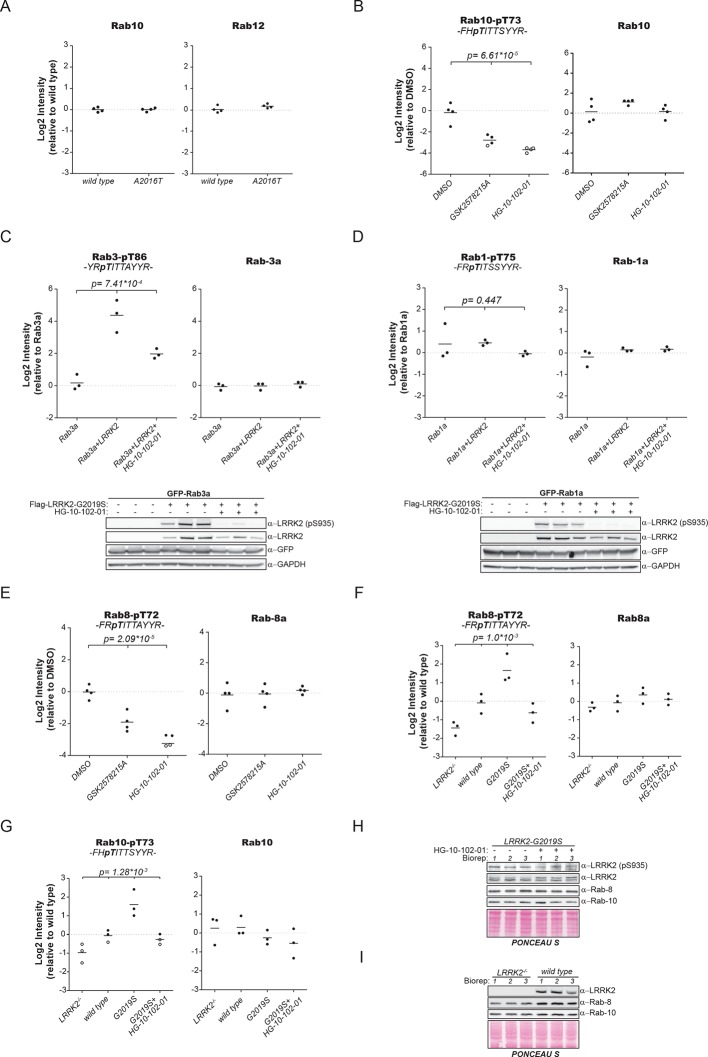
Quantification of Rab phosphorylation by mass spectrometry (MS).(A) MS-based label-free quantification (MaxLFQ, Cox et al., 2014) of the Rab10 and Rab12 protein intensities in PS2. (B) MS-based quantification of pT73-Rab10 (left) and total Rab10 (right) derived from HEK293 (trex flpIn) cells expressing GFP-LRRK2-G2019S after LRRK2 inhibition (n=4). (C) MS-quantified Rab3-pT86 peptide levels of ectopically expressed Rab3a alone or in combination with LRRK2-G2019S, in presence or absence of HG-10-102-01 (3 µM, 3 hr, n=3). A western blot of the same samples is shown below. (D) Same as (C) but Rab1a was expressed and pT75-Rab1a quantified. (E) Same as (B) with pT72-Rab8 (left) and total Rab8a (right). (F) Label-free quantification of pT73-Rab10 and (G) pT72-Rab8a from knockout, wt, G2019S, or G2019S treated with HG-10-102-01 (3 µM, 3 hr) MEFs. Total Rab10 and Rab8 protein levels were also quantified (n=3). (H) and (I) Western blot analyses of samples used in (F) and (G). Open circles indicate imputed values. MEFs, mouse embryonic fibroblasts; wt, wild type.